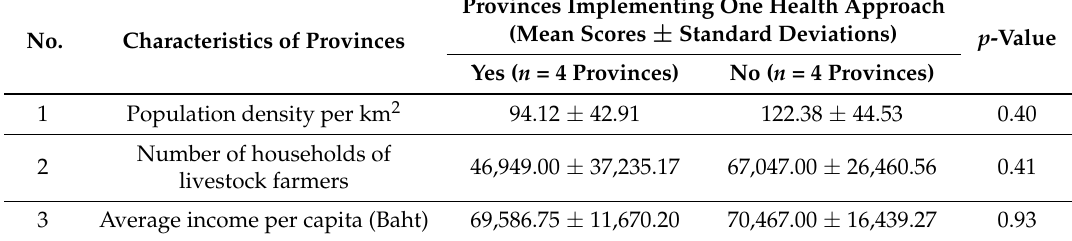
Table 1. Population characteristics between provinces that implemented the One Health approach and provinces that did not, Thailand 2016.